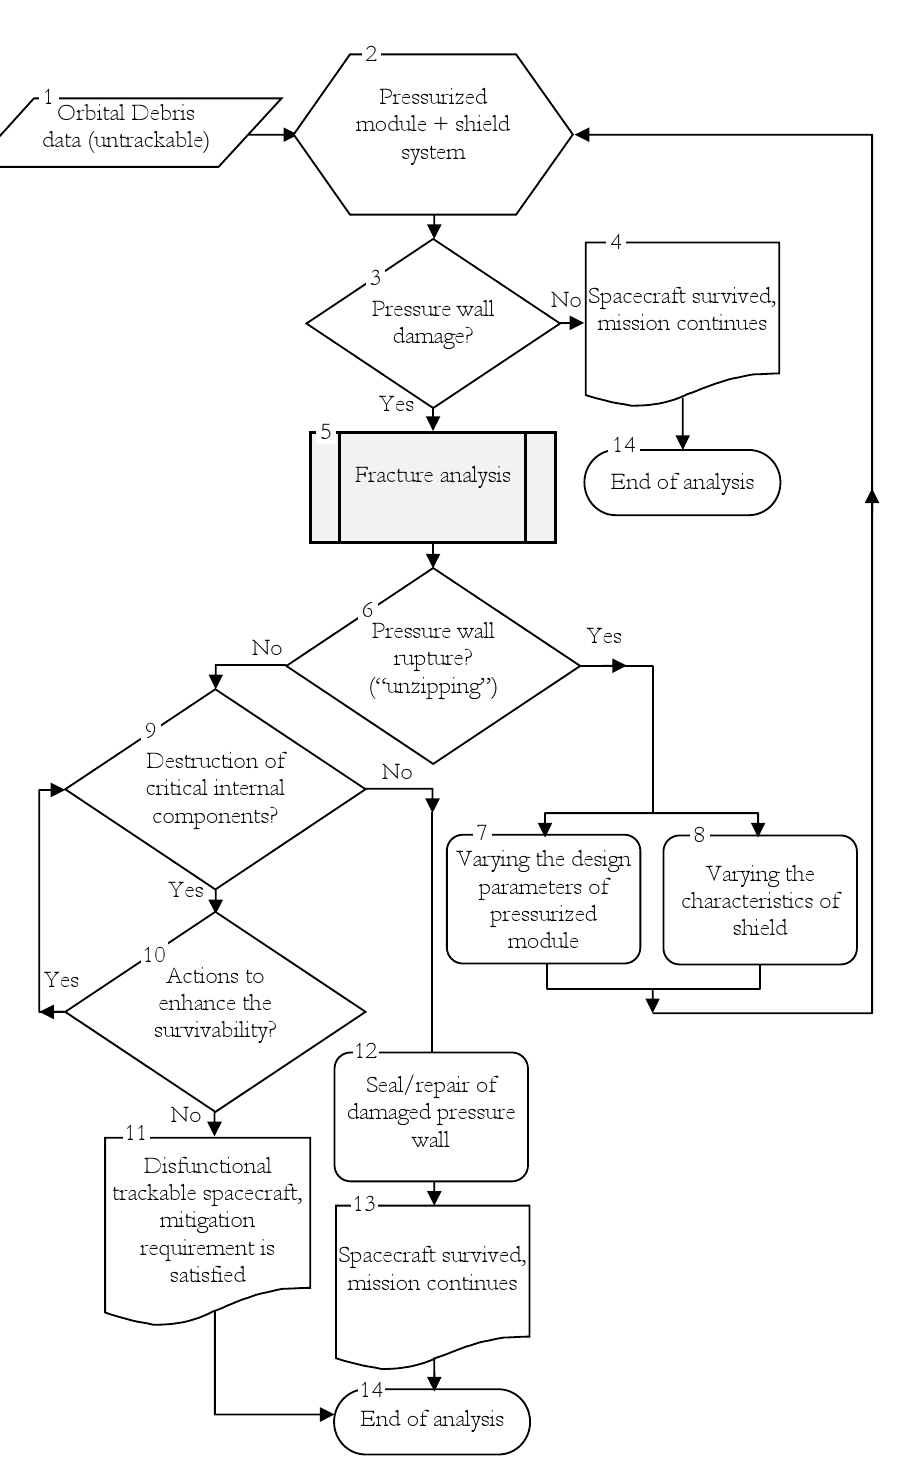
Figure 1: Design procedure of spacecraft with enhanced